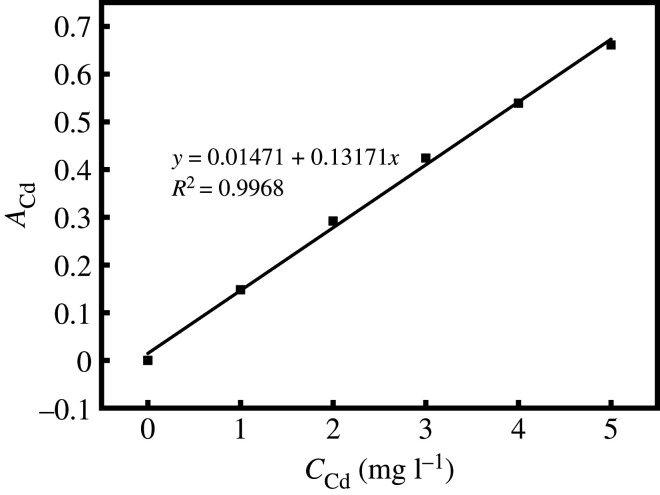
Standard curve for determining Cd2+ content.